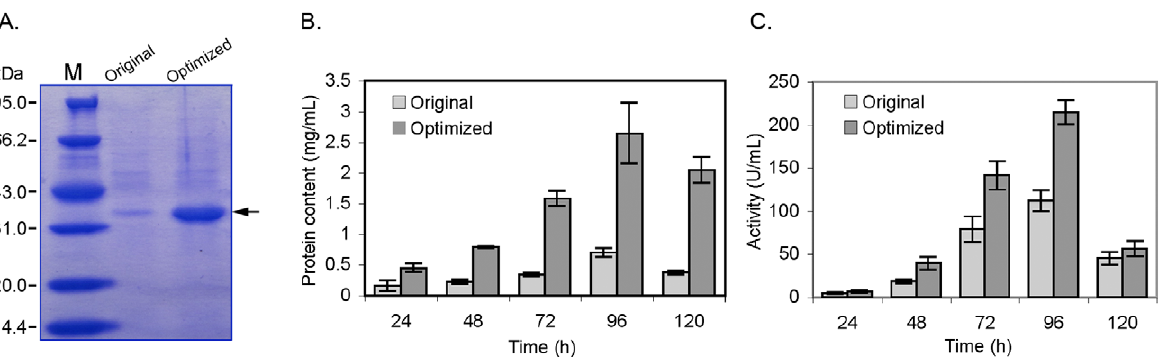
Figure 6. Expression profiles of yeast recombinants carrying original and codon optimized ROL gene ( ROL-syn ). (A) SDS-PAGE analysis of protein in fermentation broth after methanol induced for 48 h. About 20 m L protein solution per sample was loaded into the gel stained by coomassie blue G-250 after running. Protein content (B) and lipase activity (C) of fermentation broth of yeast recombinants carrying original and codon optimized ROL genes.